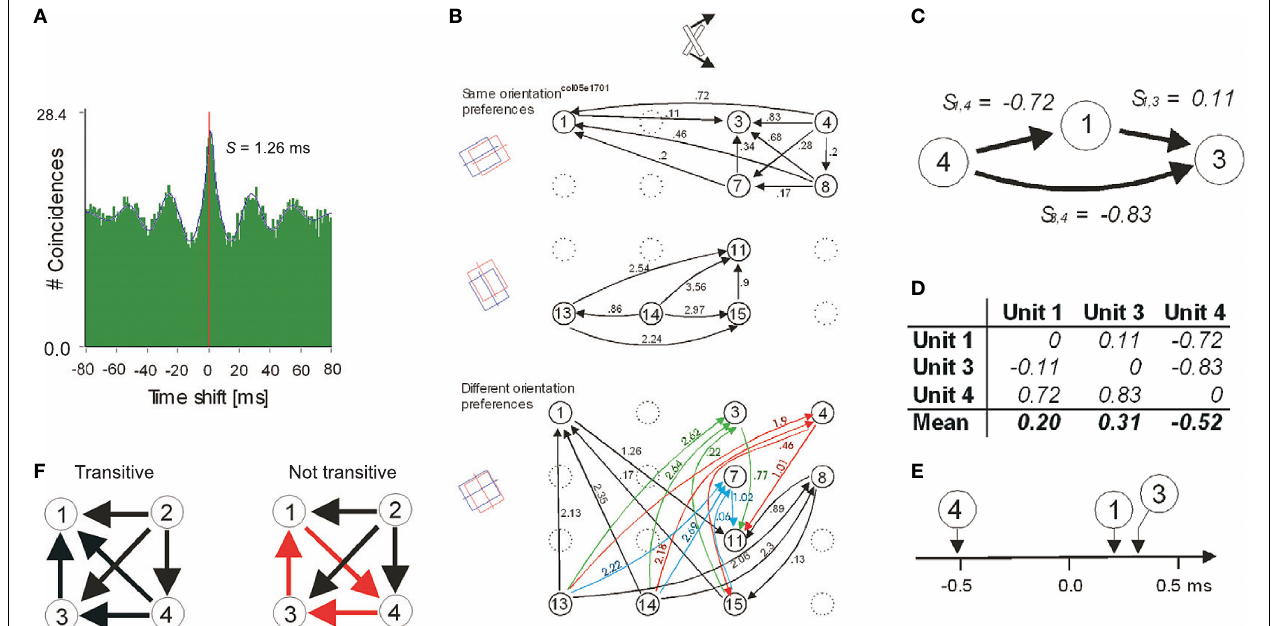
overcrowded. The upper panel indicates only the delays between the pairs of units that preferred similar stimulus orientations and the lower panel between the pairs that preferred different stimulus orientations. The orientations of the corresponding receptive fi elds are schematized on the far left and the bar stimulus illustrated on the top. (C) Excerpt from (B) indicating a case of additivity across three units precise to two-tenths of a millisecond. (D) For the example in (C) , the extraction of the relative fi ring sequence is illustrated. (E) Graphical presentation of the results in (D) . (F) Examples four-unit networks with transitive (black) and non-transitive (red) directions of delays in CCHs. Adapted from Nikolic´